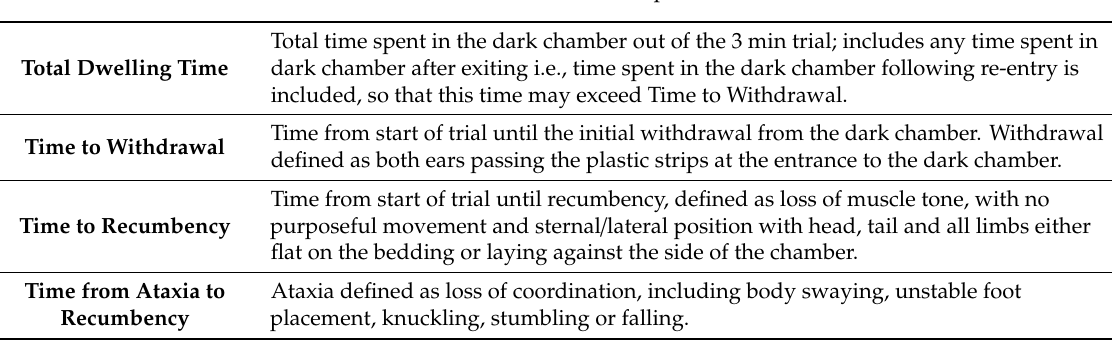
Table 2. Definitions of time